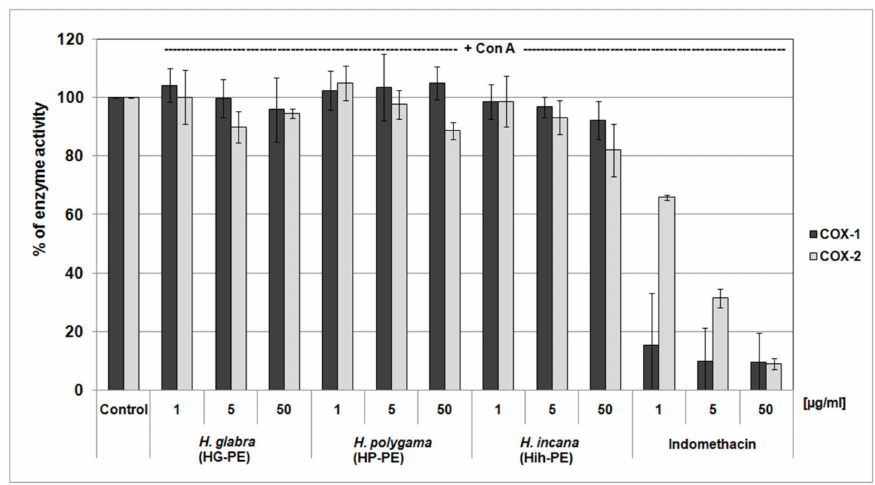
Figure 5. Screening of the cyclooxygenase-inhibitory properties of the examined Herniaria glabra (HG-PE), H. polygama (HP-PE), and H. incana herb (HIh-PE) purified extracts. The enzyme activity in control samples (untreated with the extracts or a reference inhibitor) was assumed as 100%; n = 3. However, studies on the concanavalin A (Con A) -stimulated PBMCs clearly indicated that all of the studied Herniaria PEs had some anti-inflammatory potential (Figure 6). At the highest concentration of the purified extracts (50 µ g/mL), suppression of the inflammatory response of PBMCs reached up to ≥ 80%, this was estimated by the release of interleukin 2 (IL-2) and tumor necrosis factor alpha (TNF- α ). At the lower concentrations of the tested objects (i.e., 1 and 5 µ g/mL), their effects were slighter (up to about 20–30% of cytokine level reduction), but mostly also statistically significant.